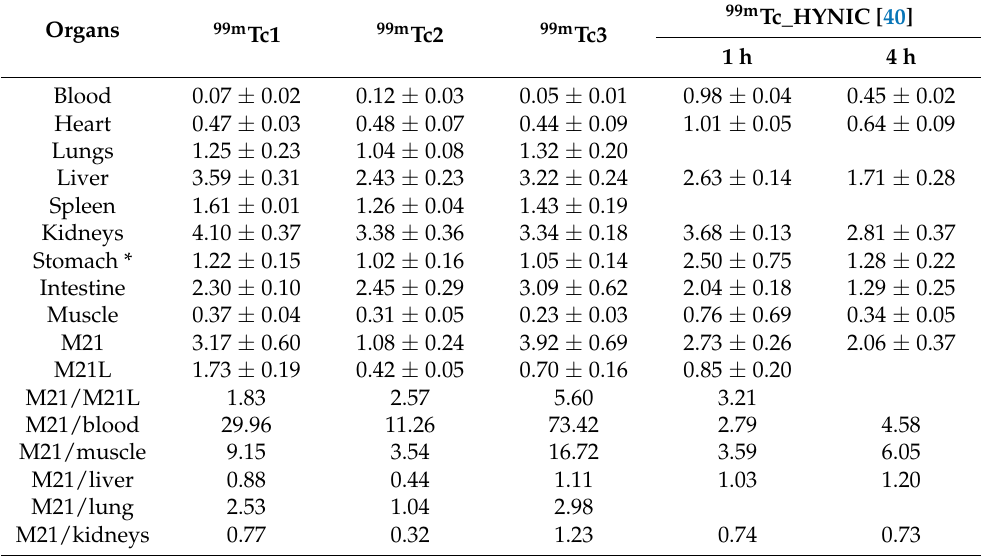
Table 5. Biodistribution studies at 120 min p.i. of 99m Tc1 , 99m Tc2 , 99m Tc3 in tumor-bearing mice (n =